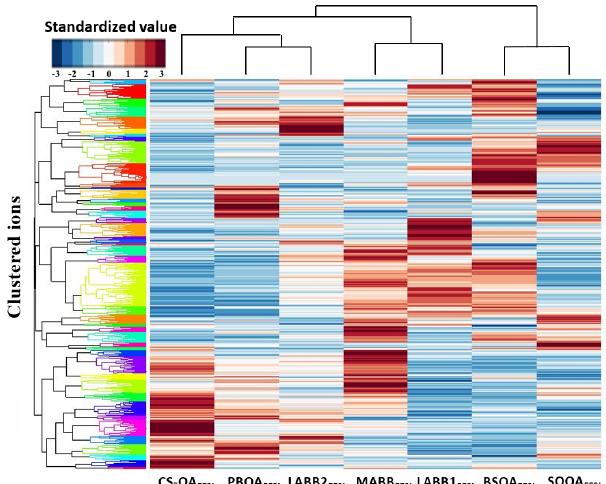
Figure 4. Standardized matrix of individual EESI-TOF ions vs. EESI-TOF PMF factors, colored by z score. Ions and factors are sorted according to the results of their respective hierarchical clus- tering analysis; the resulting dendrograms are shown on the respec- tive axes. The color of the compounds’ groups in the dendrogram are chosen to make groupings convenient to read (dendrogram col- ors are chosen arbitrarily to aid the